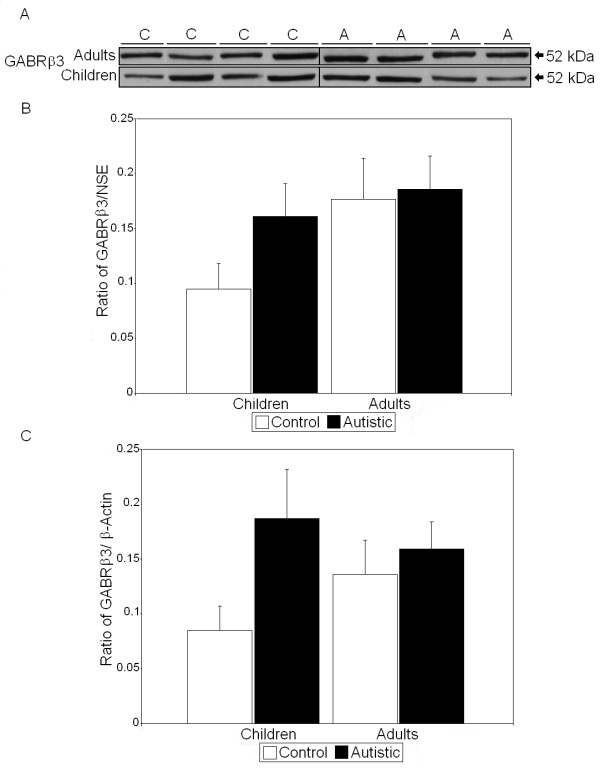
Expression of GABRβ3 in superior frontal cortex of people with autism and matched controls. (A) Representative samples of γ-aminobutyric acid (GABA) A receptor β3 (GABRβ3) from controls (C) and people with autism (A). (B) Mean GABRβ3/neuron-specific enolase (NSE) ratios for people with autism (filled histogram bars) and controls are shown for Brodmann's area 9 (BA9). (C) Mean GABRβ3/β-actin ratios for people with autism (filled histogram bars) and controls are shown for BA9. Error bars express standard error of the mean.